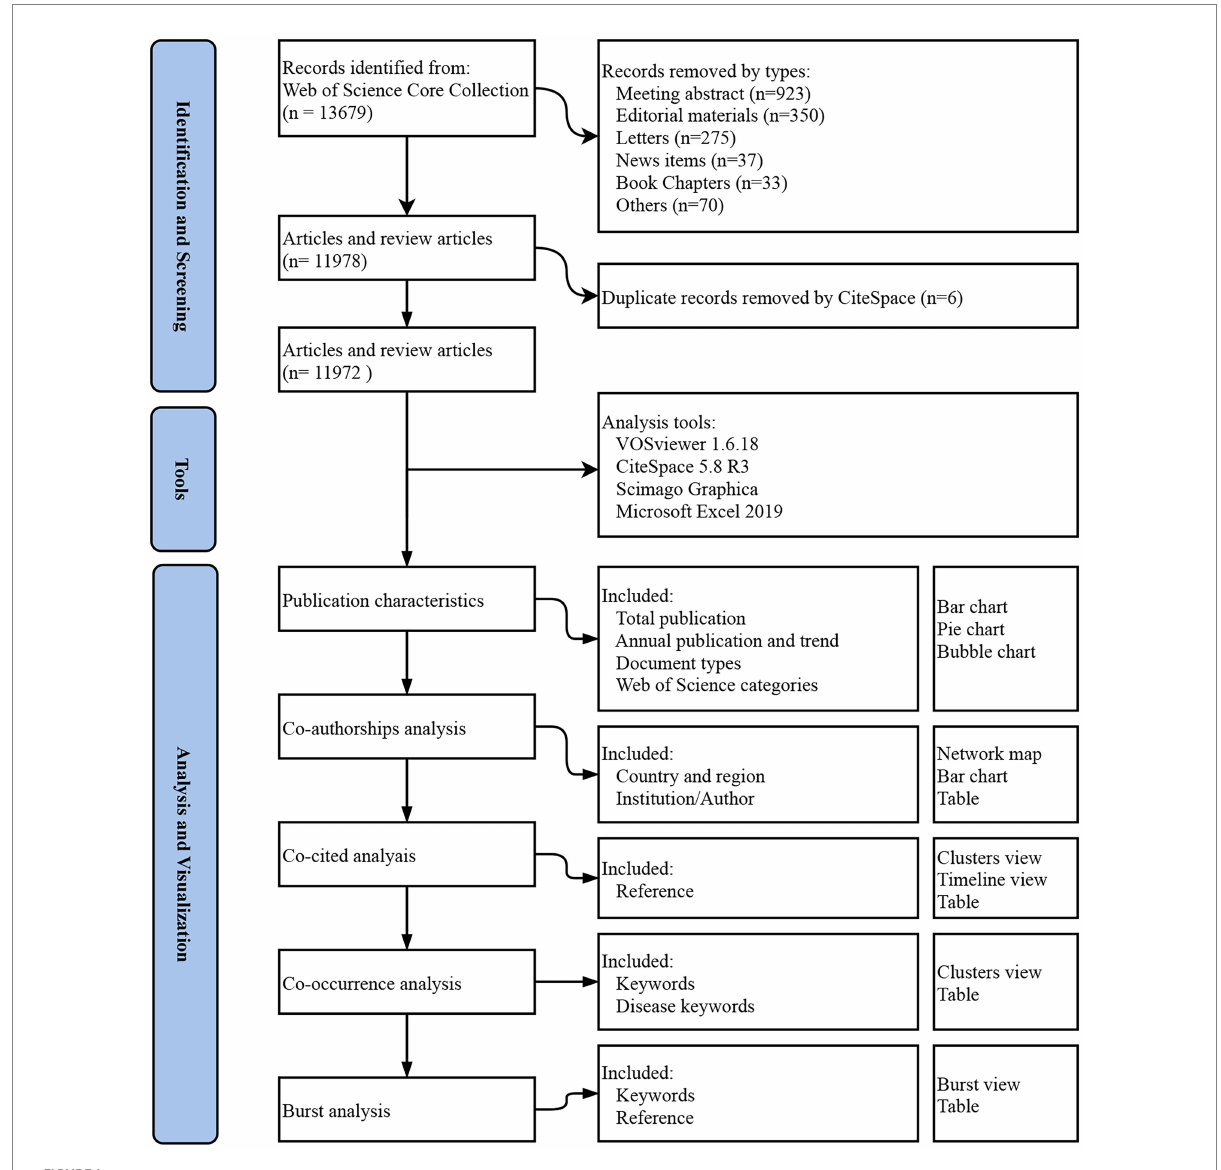
FIGURE 1 The flowchart of study identification and data